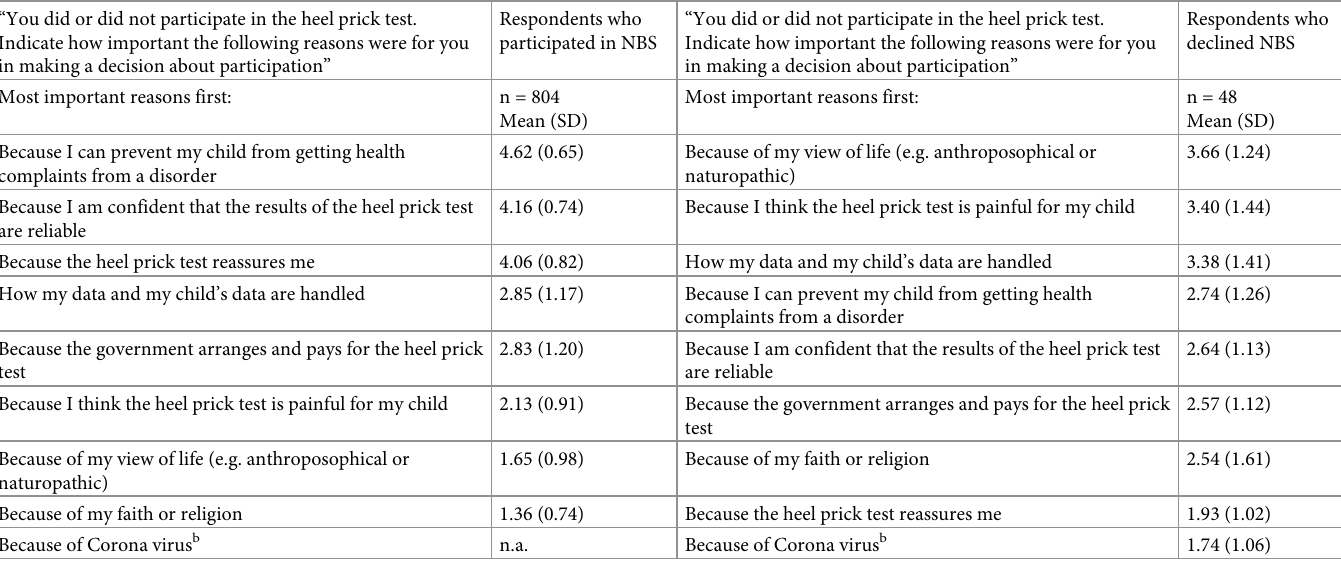
Table 2. Reasons to participate in NBS or decline NBS.